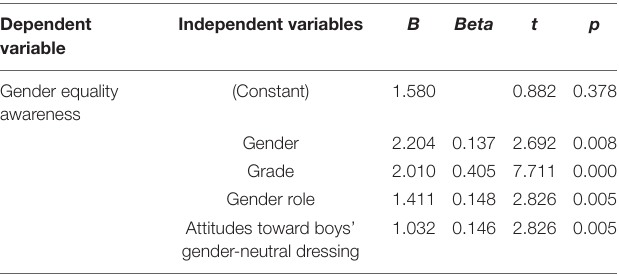
TABLE 4 | Multiple linear regression analysis of the study variables on gender equality